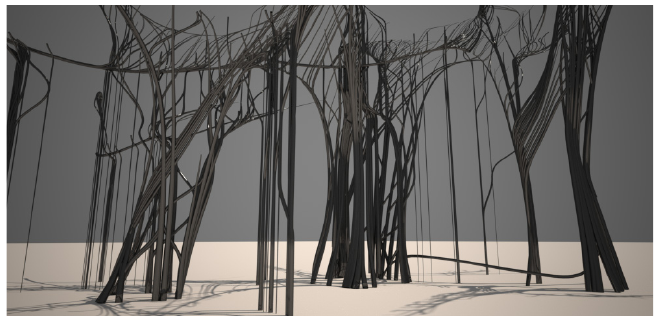
Figure 1. Simulation mimicking Banyan tree growth. ©Biornametics